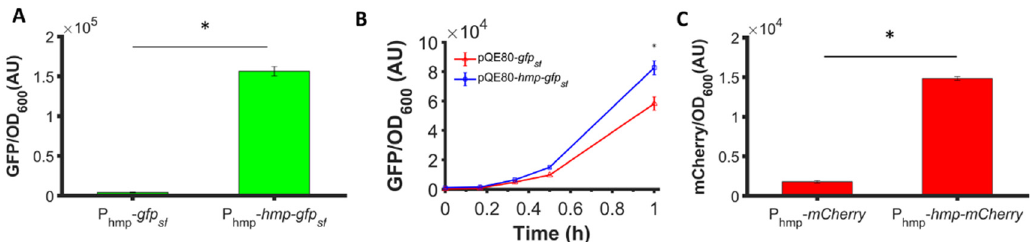
Figure 2. Hmp fusion increases the expression of sfGFP and mCherry. Shown are ( A ) GFP fluorescence measurements normalized by OD 600 after subtraction of the background signal (wild-type harboring pUA66) at each time point. Depicted are Δ nsrR harboring pUA66-P hmp - gfp sf (pXW02) and pUA66-P hmp - hmp-gfp sf (pXW01); ( B ) GFP fluorescence measurements normalized by OD 600 after subtraction of the background signal (wild-type harboring pQE80L) at each time point. Shown here are wild-type harboring pQE80-P T5 - gfp sf (pXW09) and pQE80-P T5 - hmp-gfp sf (pXW08) induced by 1 mM IPTG at time 0. Corresponding OD 600 measurements and data of uninduced samples can be found in Figure S5. ( C ) mCherry fluores- cence measurements normalized by OD 600 after subtraction of the background signal (wild-type harboring pUA66) at each time point. Depicted are Δ nsrR E. coli harboring pUA66-P hmp - mCherry (pXW06) and pUA66-P hmp - hmp-mCherry (pXW05). Data are the means of three independent replicates, and error bars represent the standard errors of the means. Asterisks (*) indicate statistically significant differences between data as assessed using t-tests and a significance threshold of p - value ≤ 0.05.